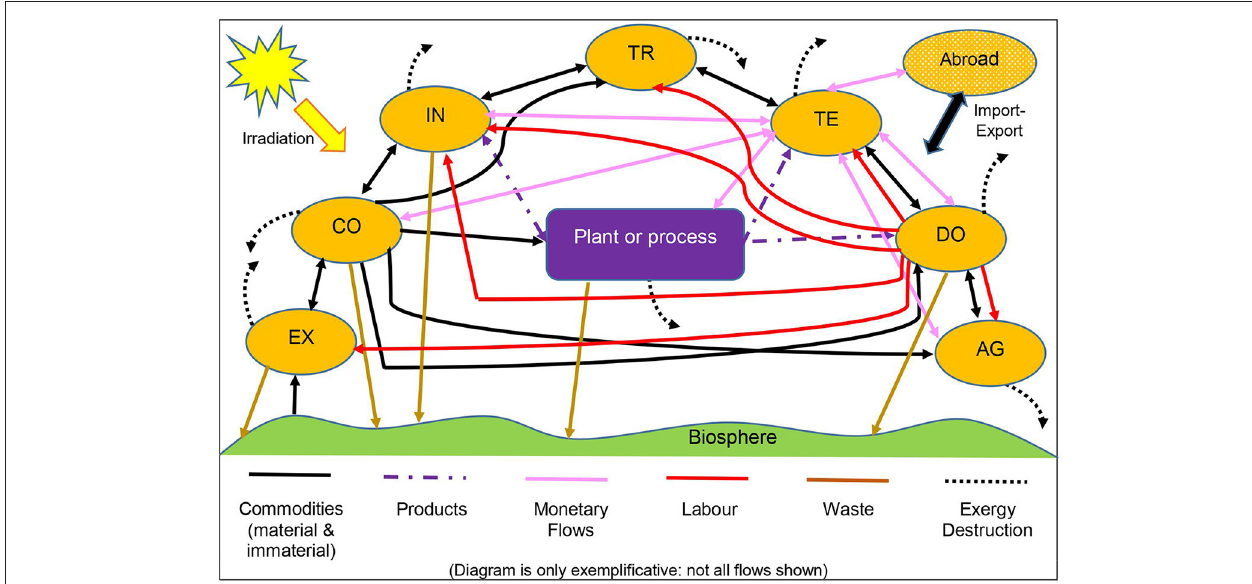
FIGURE 10 | The control volume for an Extended Exergy Accounting (EEA) analysis.